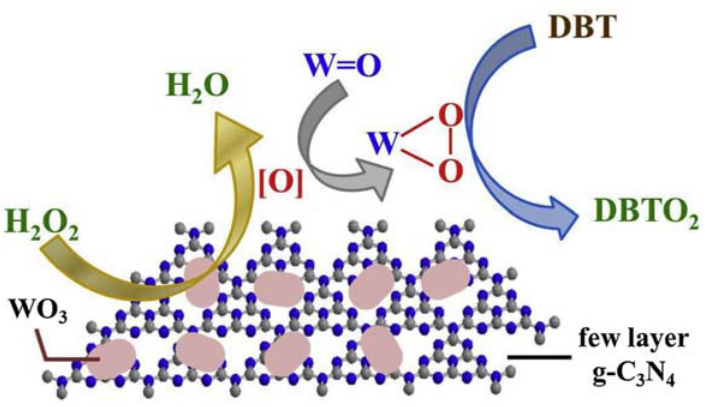
Figure 13. Possible ODS mechanism using WO 3 / few-layer g-C 3 N 4 as catalyst. Reproduced with permission [131]. Copyright 2019, Elsevier.